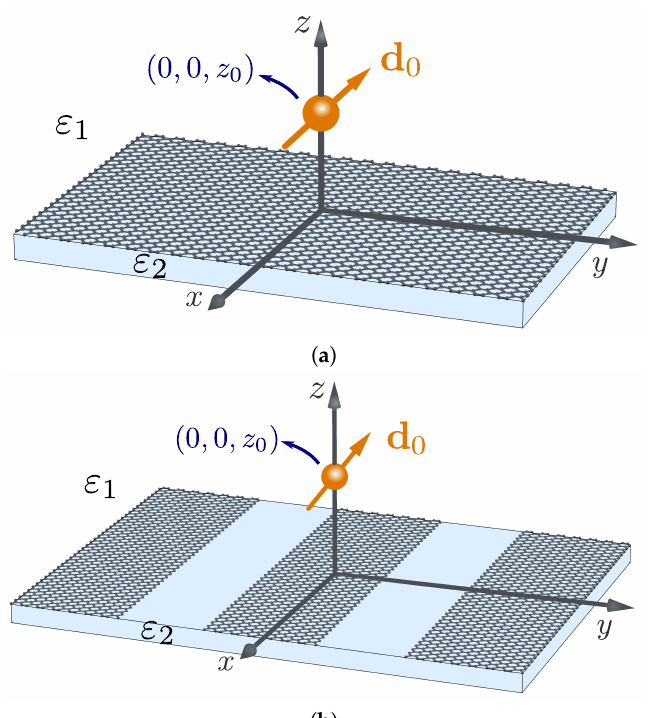
Figure 1. The two systems considered in this paper: a graphene sheet ( a ) and a graphene grid of ribbons ( b ) located in between two dielectrics. A nanoparticle is located at position r 0 = ( 0,0, z 0 ) and is characterized by a polarizability tensor α 0 in vacuum. In addition, a plane wave impinges on the nanoparticle and on graphene coming from z = + ∞